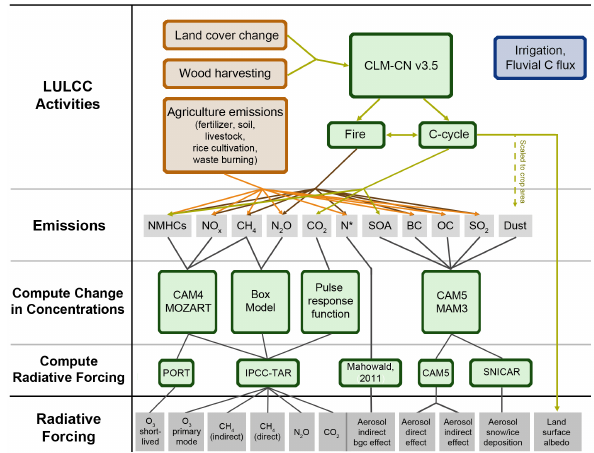
Figure 2. A flow chart summarizing the methodology used in this study to compute the RF of the various forcing agents of LULCC. The colors of the boxes indicate processes that are independent of this study (orange); processes and computational steps that were completed as part of this study (green); and processes that were not included in this study, but are likely important for climate (blue). Acronyms are defined as follows: CLM-CN (Community Land Model with Carbon/Nitrogen cycles) (Oleson et al., 2008; Stöckli et al., 2008), CAM (Community Atmosphere Model) (Gent et al., 2011), MOZART (Model for Ozone and Related Chemical Tracers) (Emmons et al., 2010), PORT (Parallel Offline Radiative Transfer) (Conley et al., 2013), TAR (Third Assessment Report) (Ramaswamy et al., 2001), and SNICAR (Snow Ice and Radiative Aerosol Model) (Flanner and Zender, 2006). ∗ : total nitrogen (N) includes contributions from NH 3 , N 2 O, and NO x